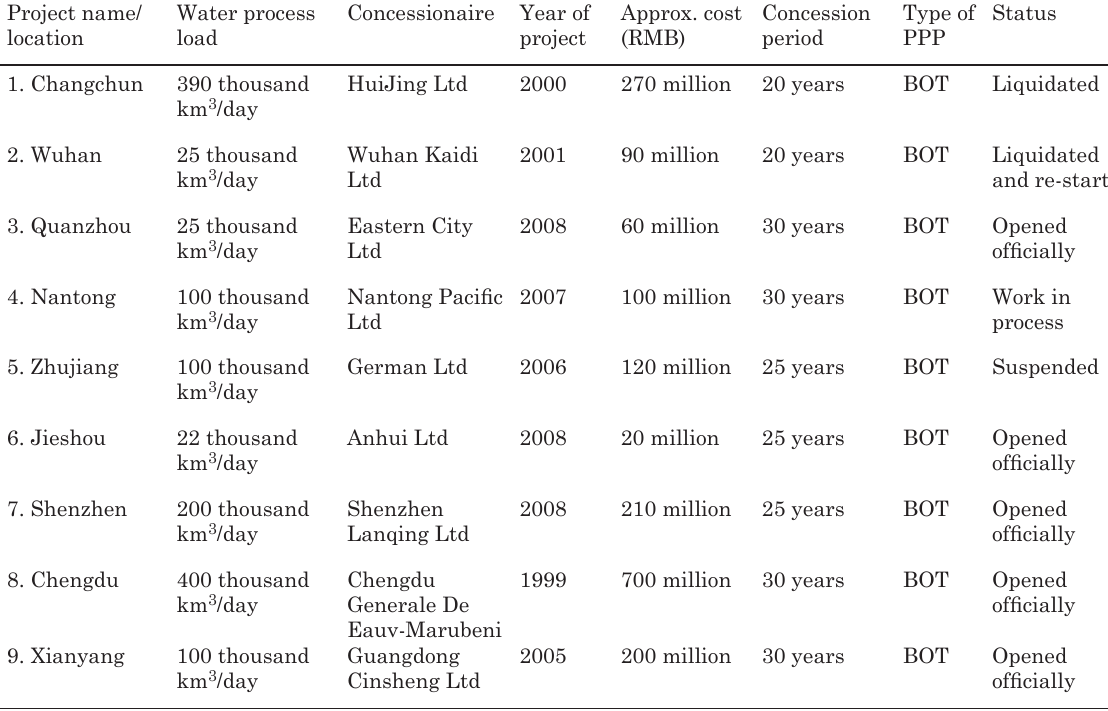
table 1. General information of the nine selected PPP water projects in China Project name/